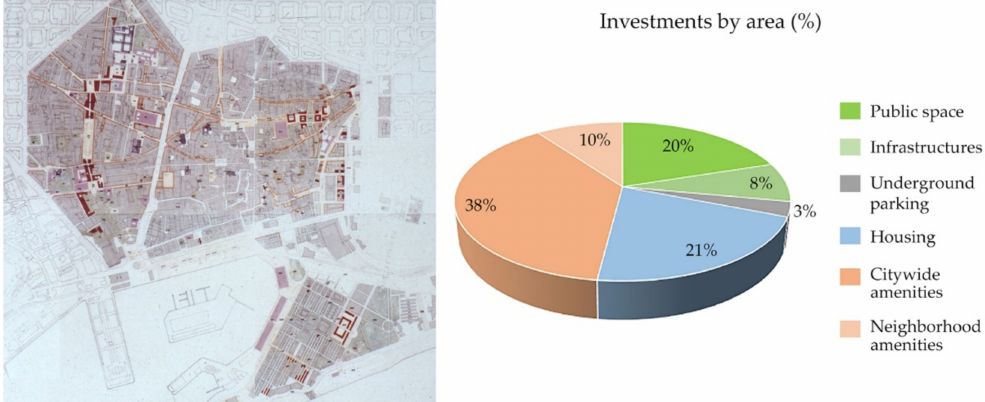
Figure 3. Map: Program of interventions in Ciutat Vella. Graph: Public investment in Ciutat Vella. Source: À rea de Rehabilitaci ó Integral (ARI) Ciutat Vella [35].